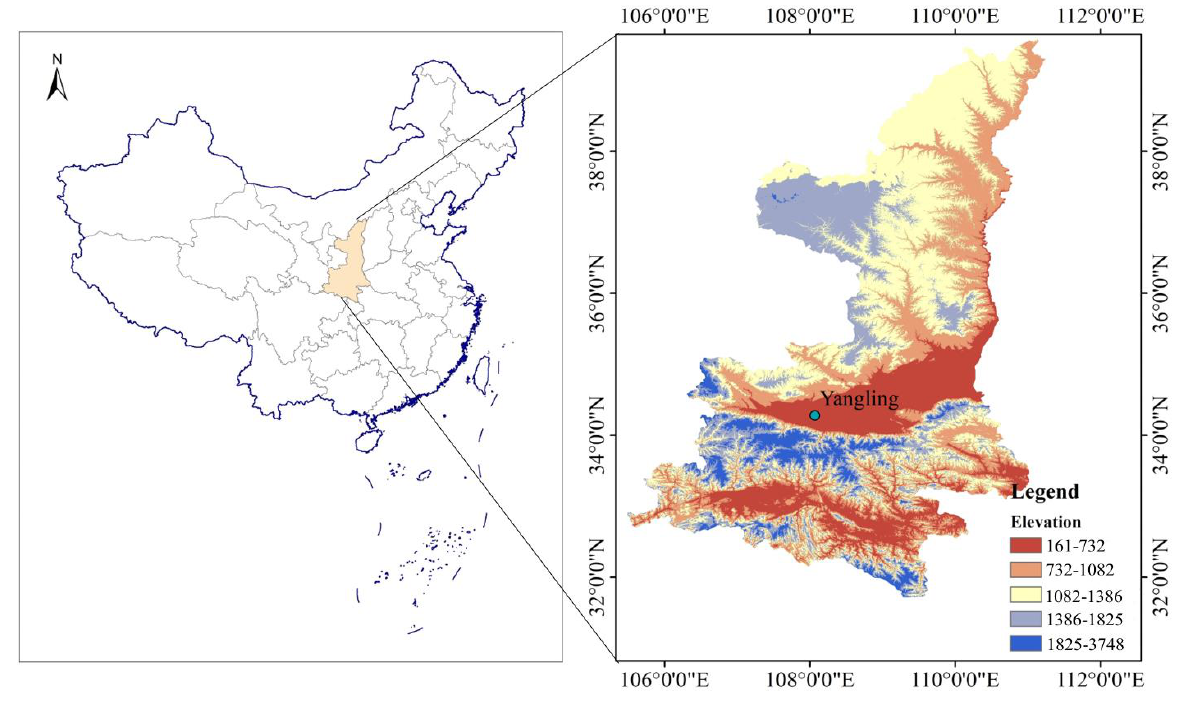
Figure 1. Study Figure 1. Study area.